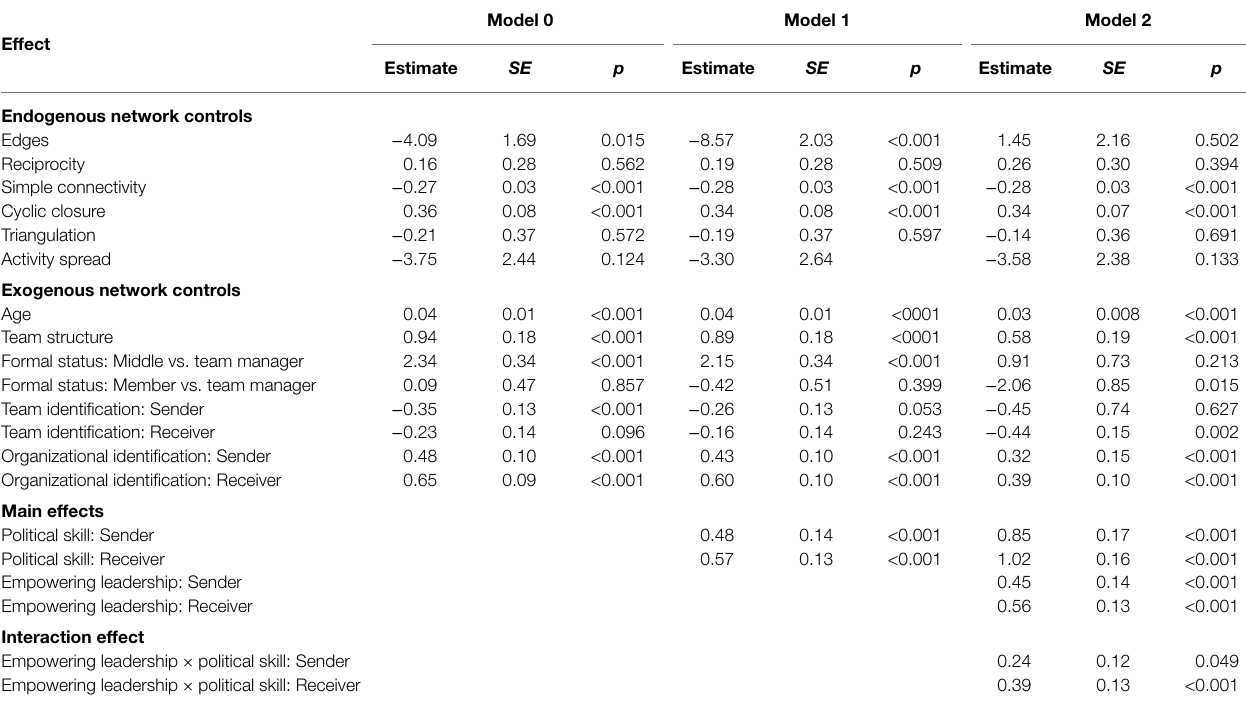
TABLE 3 | Maximum likelihood estimates of ERGMS for leadership